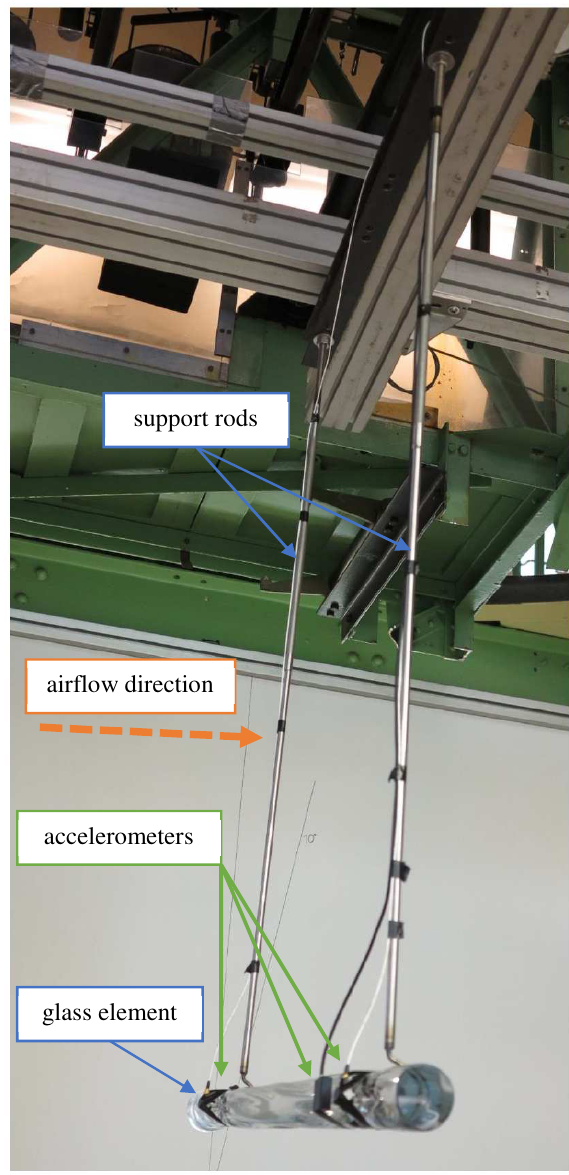
Fig. 14. Tested light sculpture element in the wind channel.